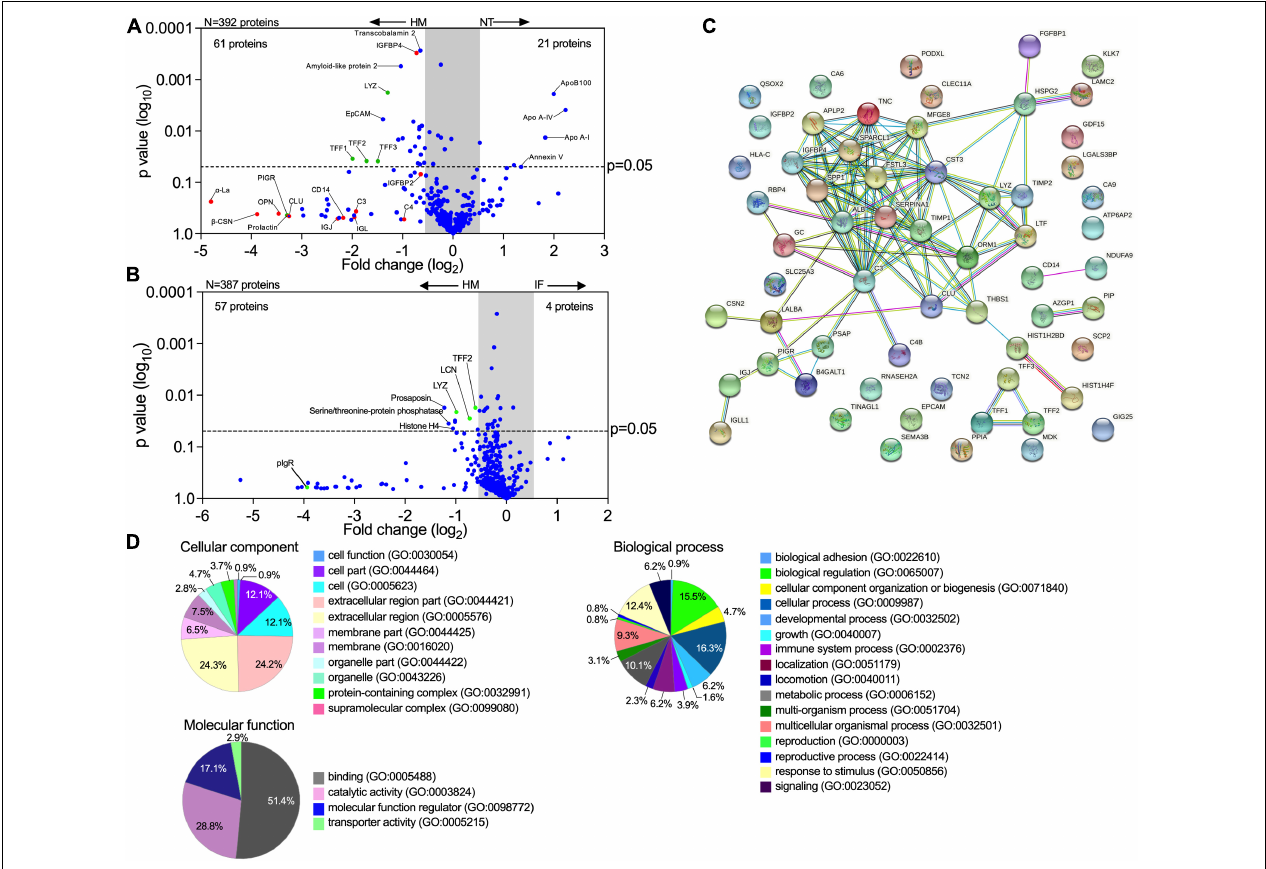
FIGURE 6 | Human milk modifies epithelial cell protein expression and basolateral secretion. (A,B) Volcano plots of differential protein abundance (high false discovery rate) in the basolateral culture supernatant of 2PD monolayers NT or treated for 48 h with 20% HM (v/v) or IF (w/v). Data represent protein secreted by up to three monolayers per condition. Red dots indicate HM unique proteins; blue dots indicate epithelial cell-derived proteins; green dots indicate proteins derived from both HM and epithelial cells. (C) Protein-protein interaction analysis of 61 upregulated proteins produced by HM-treated monolayers selected based on the cut off shown in panel (A) . High confidence interaction score = 0.700. Color line indicates types of protein-protein interactions based on co-expression (black line), co-occurrence (blue line), experimentally determined (magenta line), curated database (light blue line) and textmining search (green line). (D) Enrichment analysis of GO terms annotated for cellular component, molecular function, and biological process of the 61 upregulated proteins as described in panel (A)